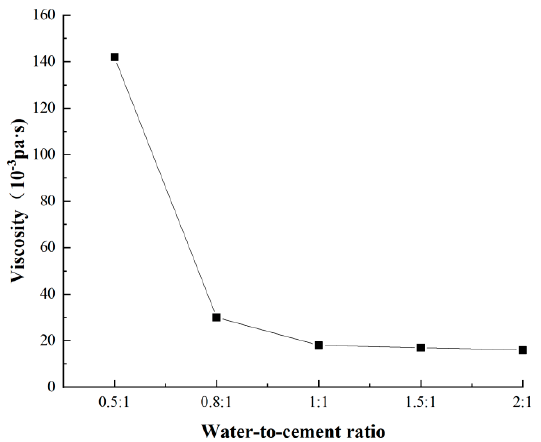
Figure 1. The influence of the water–cement ratio on the viscosity of the slurry.